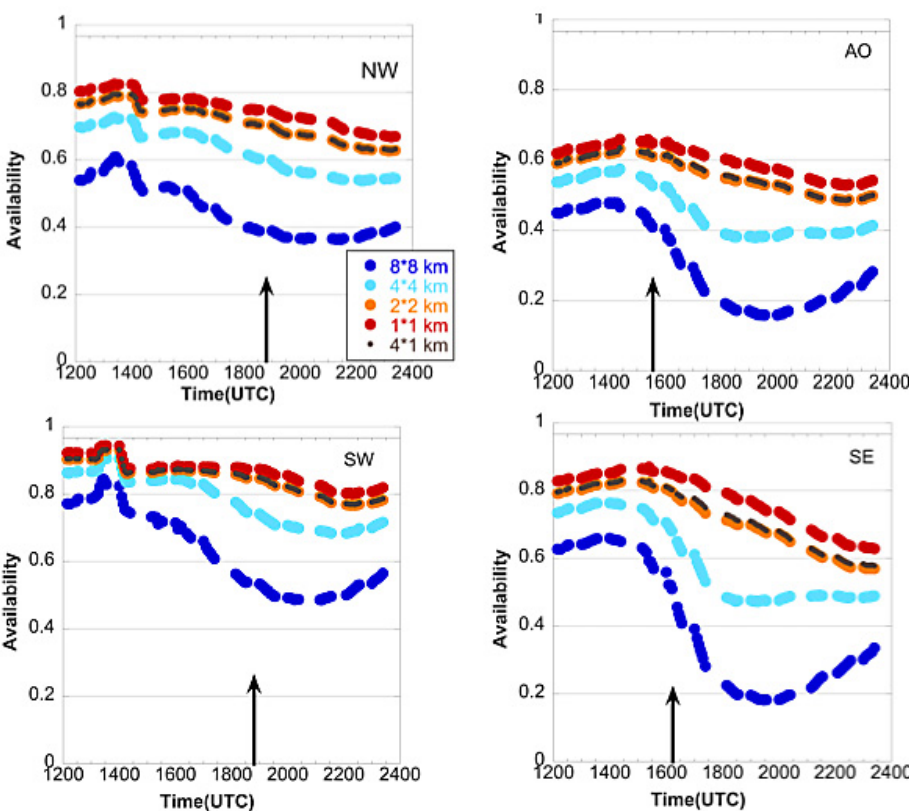
Fig. 10. Diurnal patterns of aerosol retrieval availability on 12 August 2010 for four different spatial resolutions for four subdomains, Northwest (NW), Atlantic Ocean (AO), Southwest (SW) and Southeast (SE), defined in Fig. 5. The availability was calculated using the GOES-R cloud mask applied to one day of GOES radiances archived at 5-min temporal resolution. The black arrows indicate time of Terra overpass. The 4 × 1km is denoted by small brown circles that are almost exactly overlaid onto the 2 × 2km orange